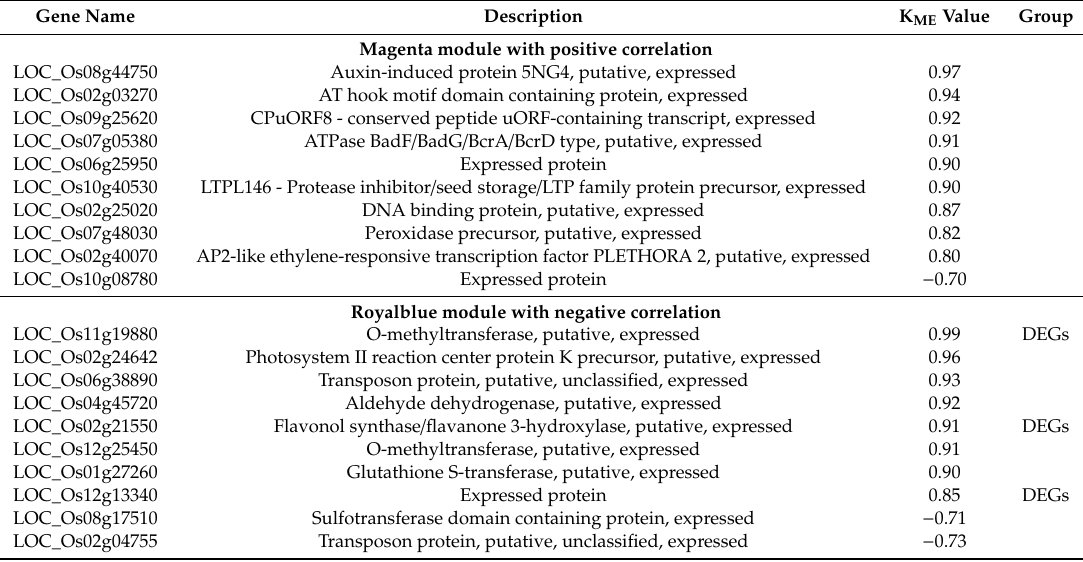
Table 1. Candidate hub genes associated with the scale of length and surface area.